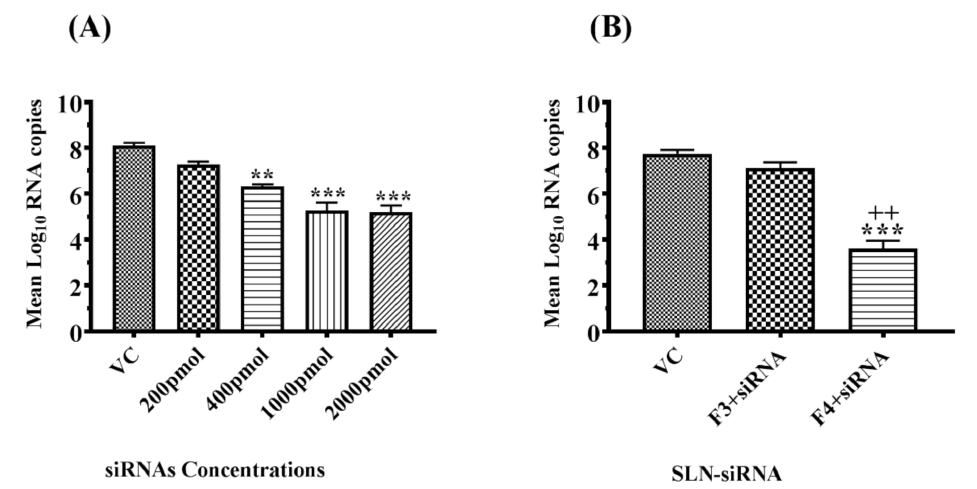
Figure 5. ( A ) Effect of transfection of different siRNA concentrations using lipofectamine reagent against CHIKV at 24 h treatment using qRT-PCR analysis, ( B ) Transfection efficiency comparison between F-3 and F4 RT-PCR results. All the values are expressed as mean ± SEM ( n = 3); ** p < 0.01, *** p < 0.001 vs. VC, virus control group; ++ p < 0.01 vs. F3 + SiRNA treated